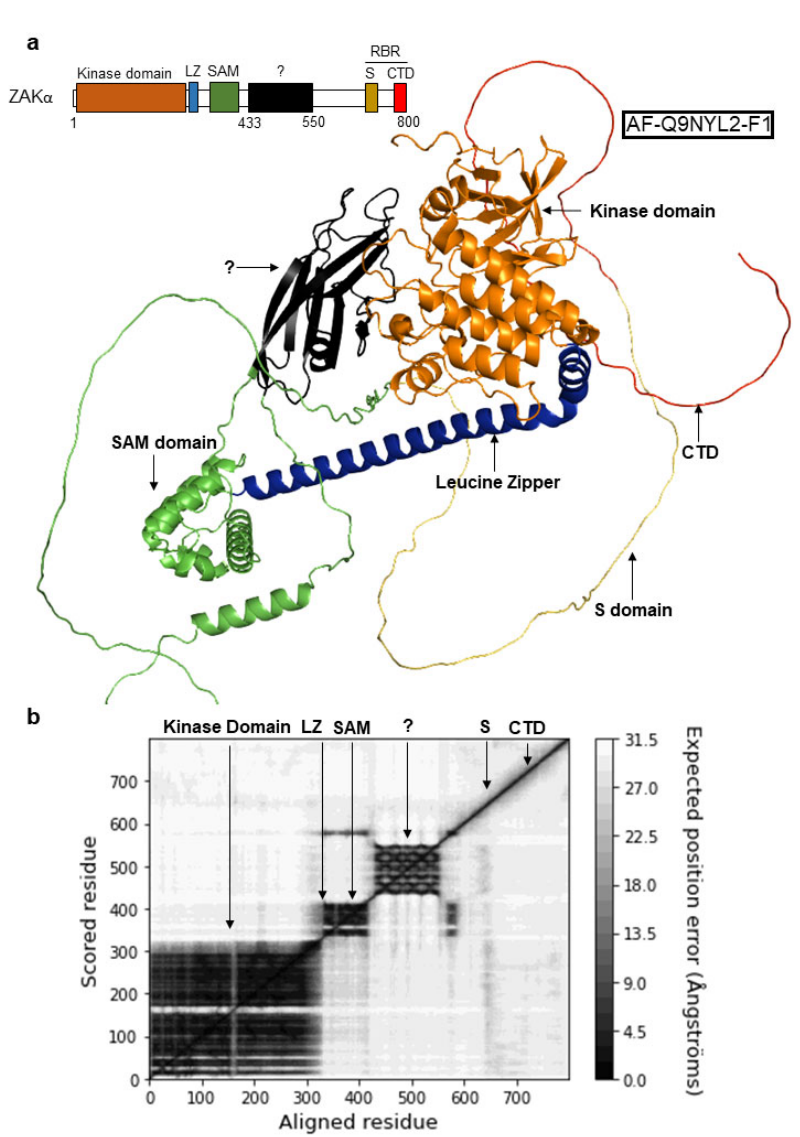
Figure 2. AlphaFold predicts the presence of an unannotated structural domain in ZAK α . ( a ) AlphaFold-predicted three-dimensional structure of human ZAK α (AF-Q9NYL2-F1 model version 1 of PDB entry Q9NYL2). Annotations of annotated and unannotated structurally predicted domains correspond to the schematic (top left). ( b ) Predicted aligned error (PAE) plot of residue pairs from the AlphaFold database. The plot was made from the AlphaFold JSON PAE file by creating an 800 × 800 array with the PAE values for each amino acid residue pair. Folded protein domains are indicated by black arrows. LZ, Leucine Zipper; SAM, Sterile Alpha Motif; S, Sensor Domain; CTD, C-Terminal Domain; and RBR, Ribosome Binding Region.